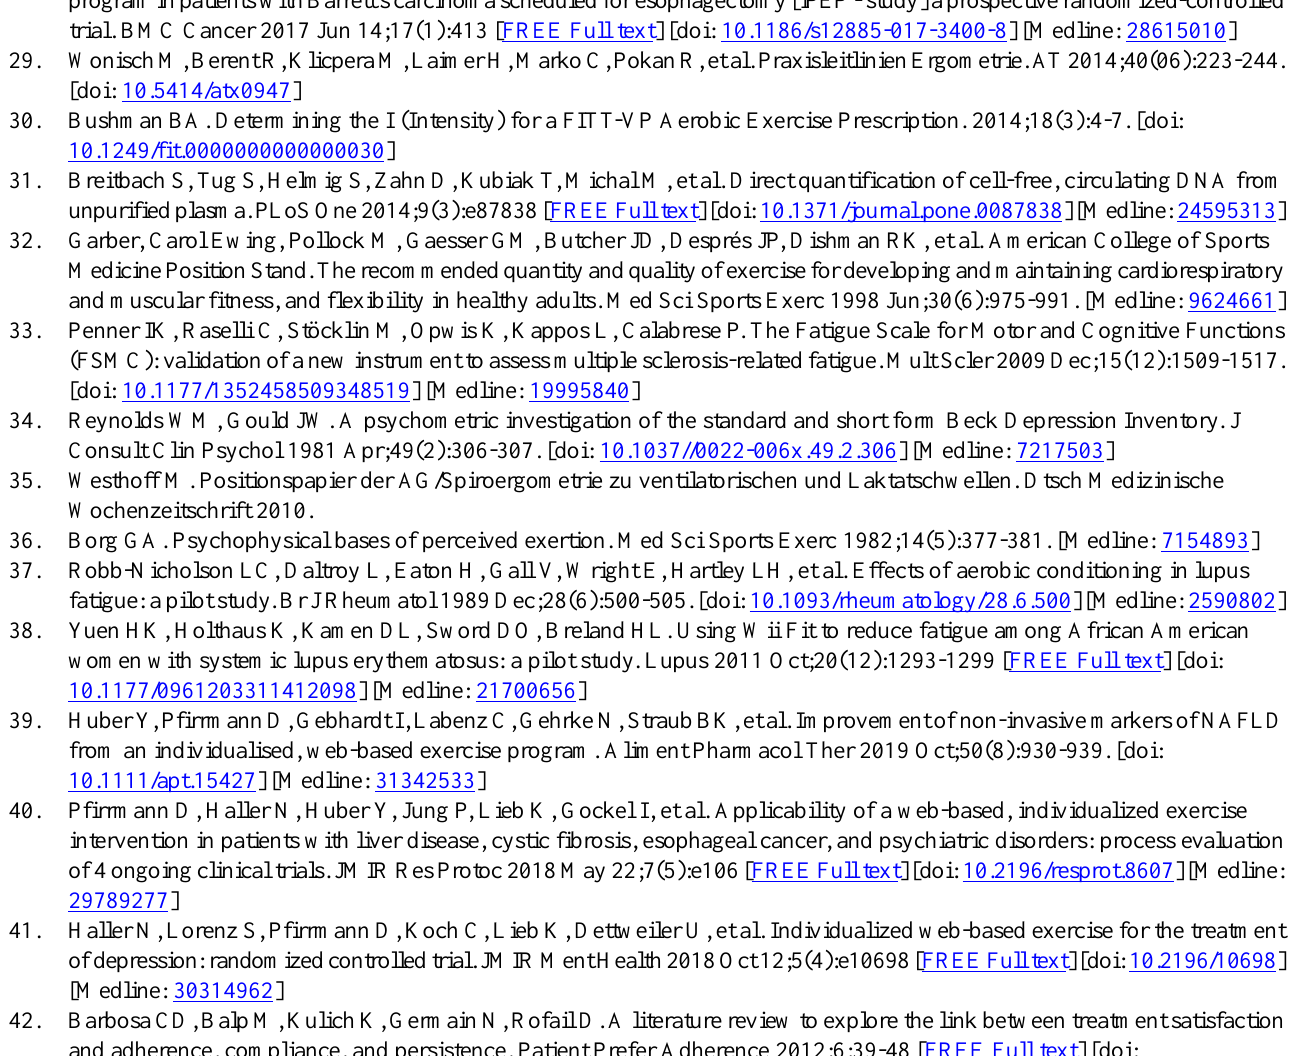
ECG: electrocardiography FITT-VP: frequency, intensity, type, time, volume, and progression VO2 peak: peak oxygen